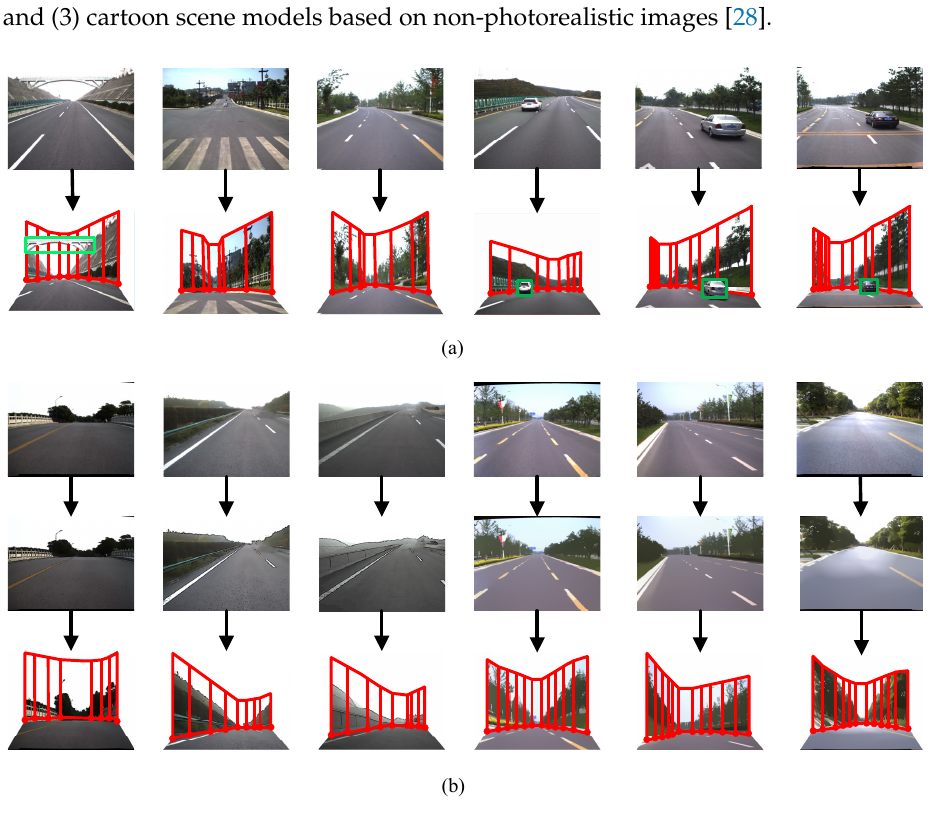
Figure 10. Construction of scene models. ( a ) traditional scene models; ( b ) cartoon scene